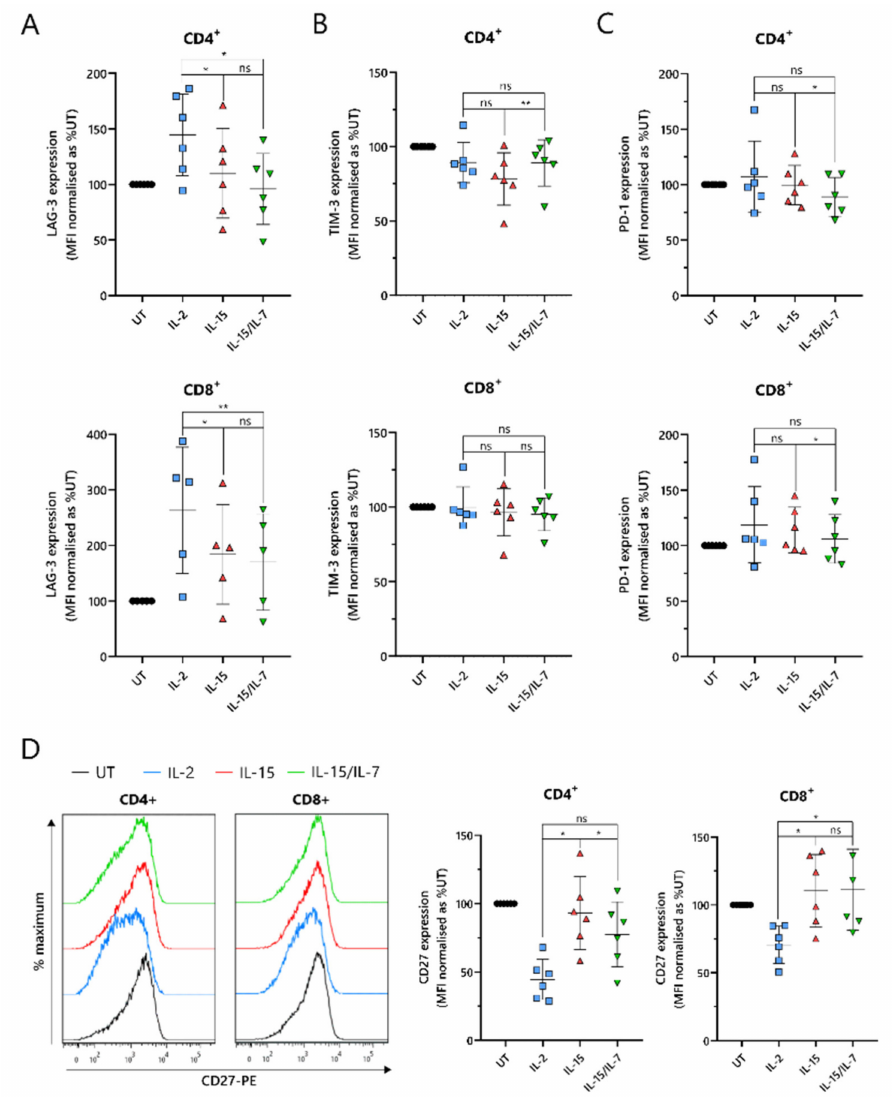
Figure 5. Expression of T-cell dysfunction markers on ARI2h BCMA-CARs. Summary of the surface expression of LAG-3 ( A ), TIM-3 ( B ), PD-1 ( C ) and CD27 ( D —right) on day 9 in vitro-cultured CD4 + and CD8 + (UT) or CAR + CD4 + and CD8 + (ARI2h IL-2 , ARI2h IL-15 and ARI2h IL-15/IL-7 ) T cells, based on the MFI of the staining and normalized to UT. Representative histograms of CD27 staining are also shown ( D —left) ( n = 6). * p < 0.05; ** p < 0.01; ns, not